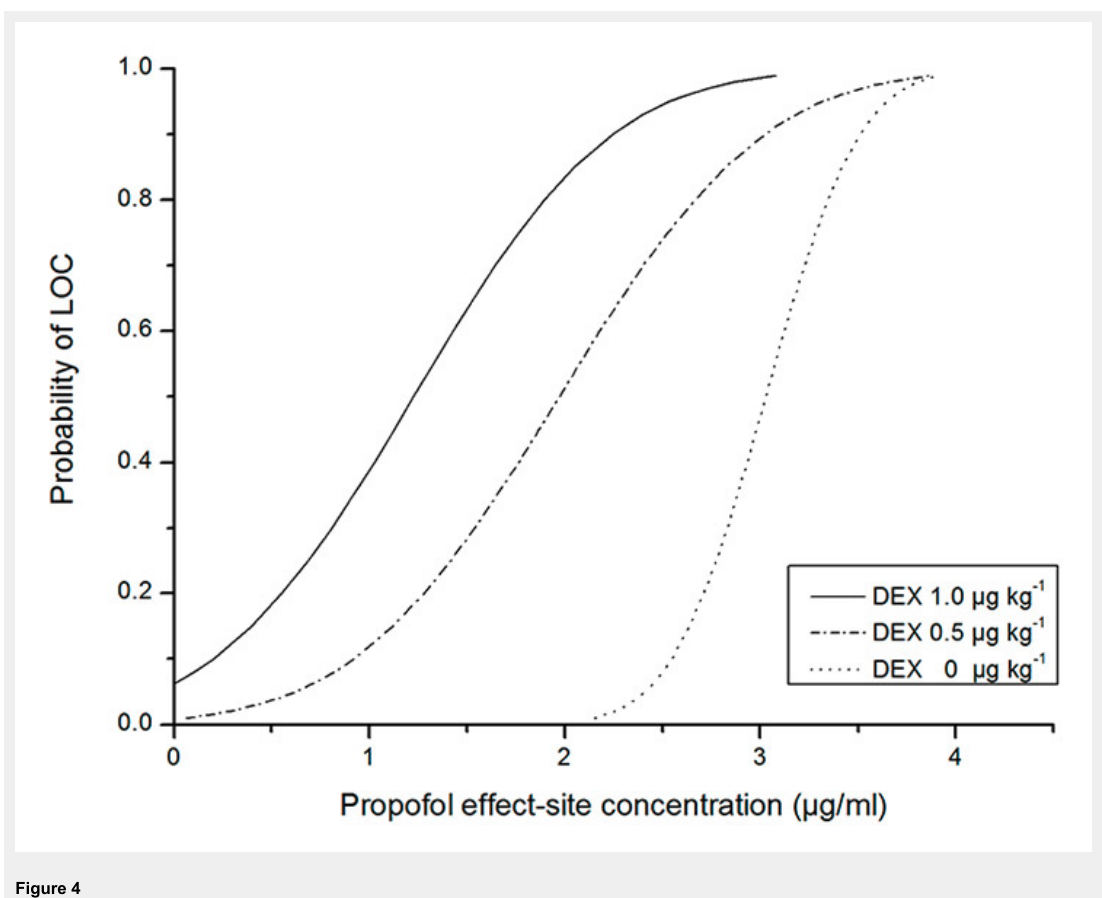
Figure 4 The relationship between the probability of loss of consciousness (LOC) and the propofol effect-site concentration. (DEX =